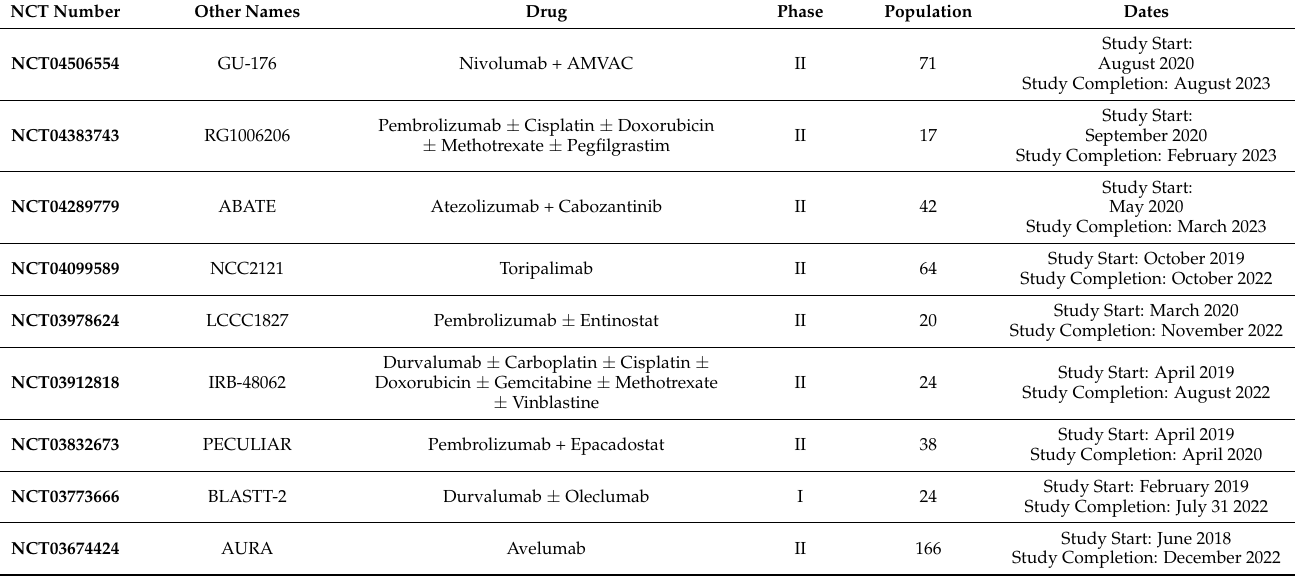
Table 1. Summary of ongoing clinical trials in neoadjuvant